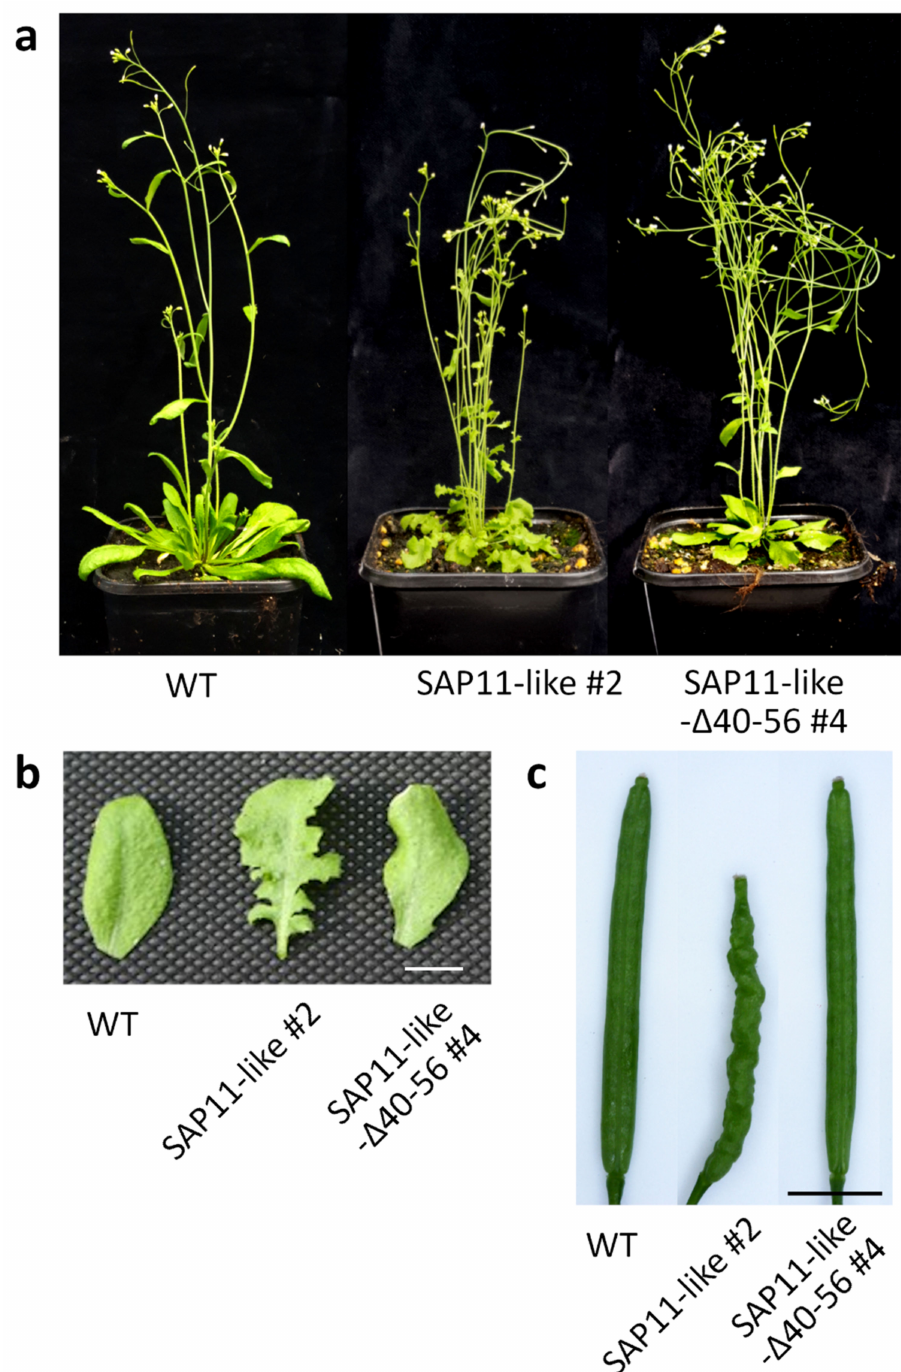
Figure 4. Amino acids 40 to 56 of AP_SAP11-like_PM19 protein are required for symptom develop- ment in A. thaliana . ( a ) Transgenic A. thaliana lines expressing AP_SAP11-like_PM19 (SAP11-like) and AP_SAP11-like_PM19 ∆ 40–56 (SAP11-like- ∆ 40–56) under the control of the Cauliflower mosaic virus 35S promoter compared to the wt Arabidopsis Col-0 plant. All plants were grown for 8 weeks in long-day (16 h/8 h light/dark) conditions. For each of the three constructs, at least 3 lines were examined, all showing similar phenotypic characteristics. ( b ) Leaves of transgenic plant lines shown in ( a ). Scale bar = 1 cm. ( c ) Siliques of transgenic lines shown in ( a